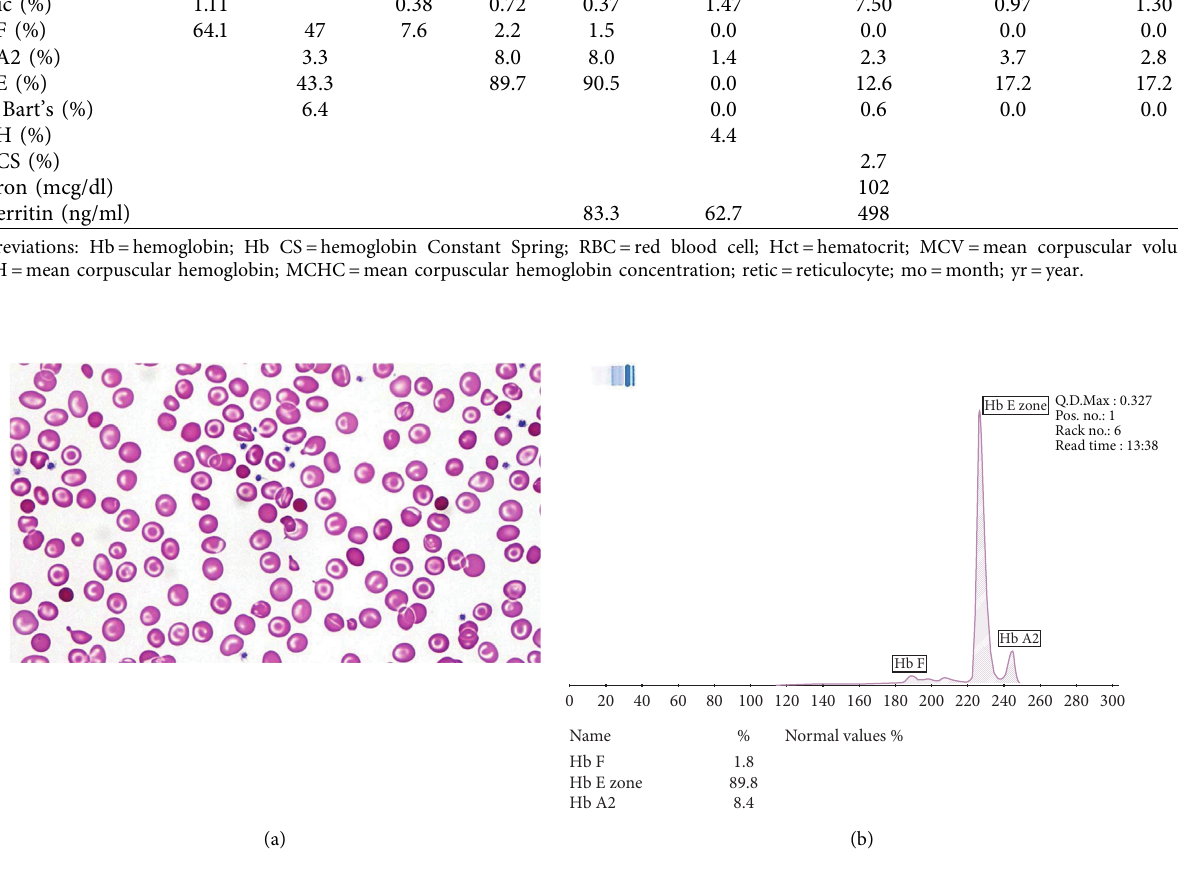
Figure 1: (a) Photomicrographs of Wright-stained peripheral blood film showing microcytosis and hypochromasia. There are multiple- target red blood cells and rare spherocytes and teardrop cells (Wright stain, 1000x). (b) Capillary hemoglobin electrophoresis pattern demonstrating homozygote hemoglobin E (HbE) variant and elevated hemoglobin A2 (HbA2) with the absence of hemoglobin A1 (HbA1) in the peripheral blood sample.